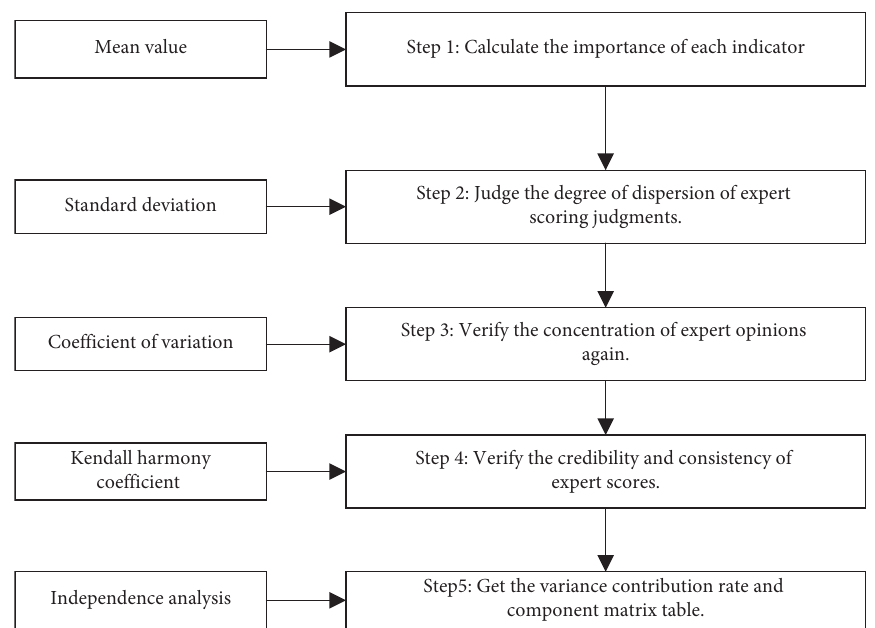
Figure 1: Calculation steps of each index